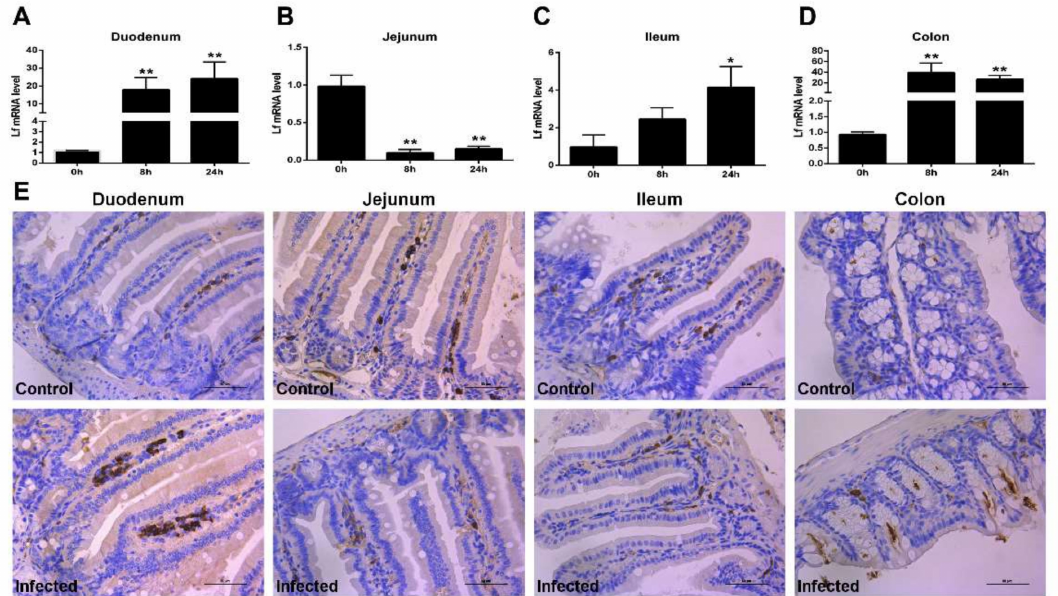
Figure 2. Developmental expression and distribution of Lactoferrin (Lf). ( A – D ) E. coli K88 infection changed the mRNA expression of Lf in mice intestine including the duodenum, jejunum, ileum and colon with time di ff erences. ( E ) Representative immunohistology-stained section from the duodenum, jejunum, ileum and colon at 0 and 24 h post infection. Original magnification 400 × . Formalin-fixed, para ffi n-embedded 5-mm cross-sections were stained with a primary Ab to Lf. Data are presented as the mean ± SD, n = 6. The values were normalized against the level of GAPDH gene. * Indicates a significant di ff erence ( p < 0.05) and ** Indicates an extremely significant di ff erence ( p < 0.01) compared to that of control group or 0 h post